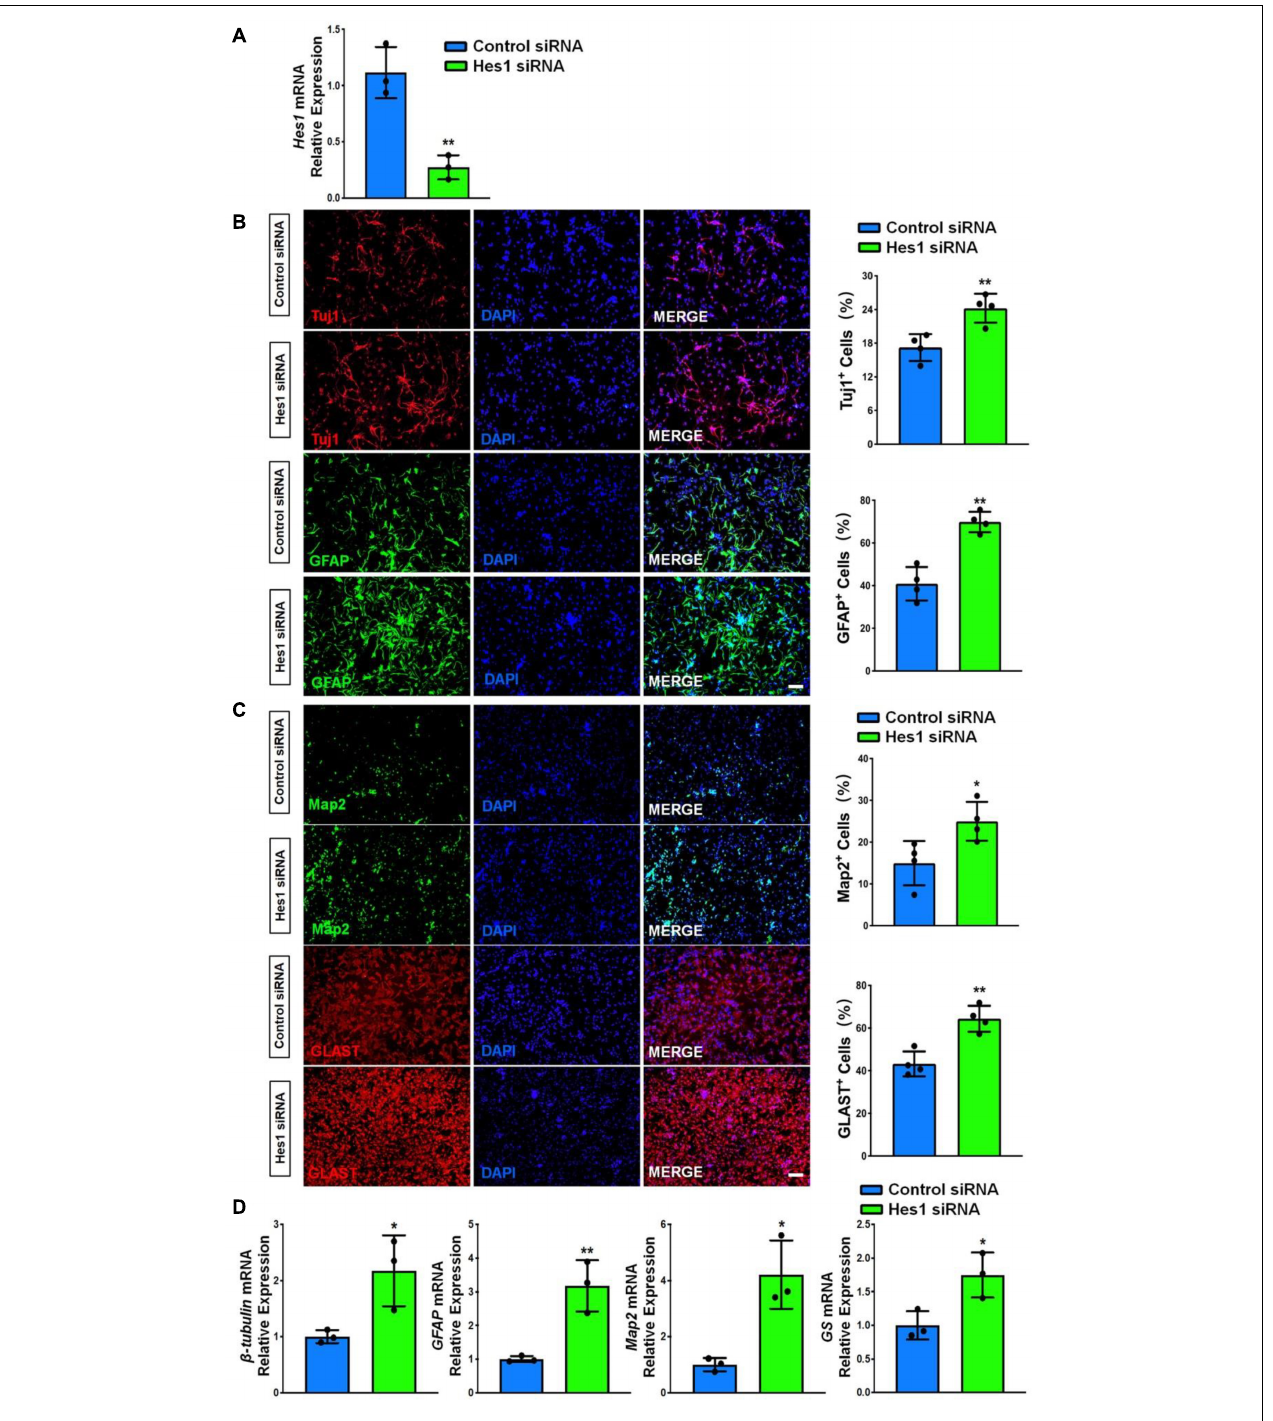
FIGURE 8 | Hes1 loss-of-function enhances NSC differentiation. (A) NSCs transfected with either Hes1 siRNA or scrambled control were cultured for 6 days in differentiation conditions. The transfection efficiency was determined by quantifying the intracellular Hes1 expression levels via RT-qPCR analysis. (B) Representative images of pre-mature cell markers (Tuj1 and GFAP) staining were shown. Proportions of cells exhibiting immunoreactivities of pre-mature cell markers (Tuj1 + and GFAP + ) were determined (in the right panel). (C) Representative images of matured cell markers (Map2 and Glast) staining were shown. Proportions of cells exhibiting immunoreactivities of pre-mature cell markers (Map2 + and Glast + ) were determined (in the right panel). (D) The expression levels of transcripts corresponding to pre-mature cell markers ( β III-tubulin and GFAP ) and matured cell markers ( Map2 and GS ) was determined by RT-qPCR analysis. Data were represented as mean ± SE from three independent experiments. * and ** denote p < 0.05 and p < 0.01, respectively. Scale bar 100 µ m in panel (B,C) .